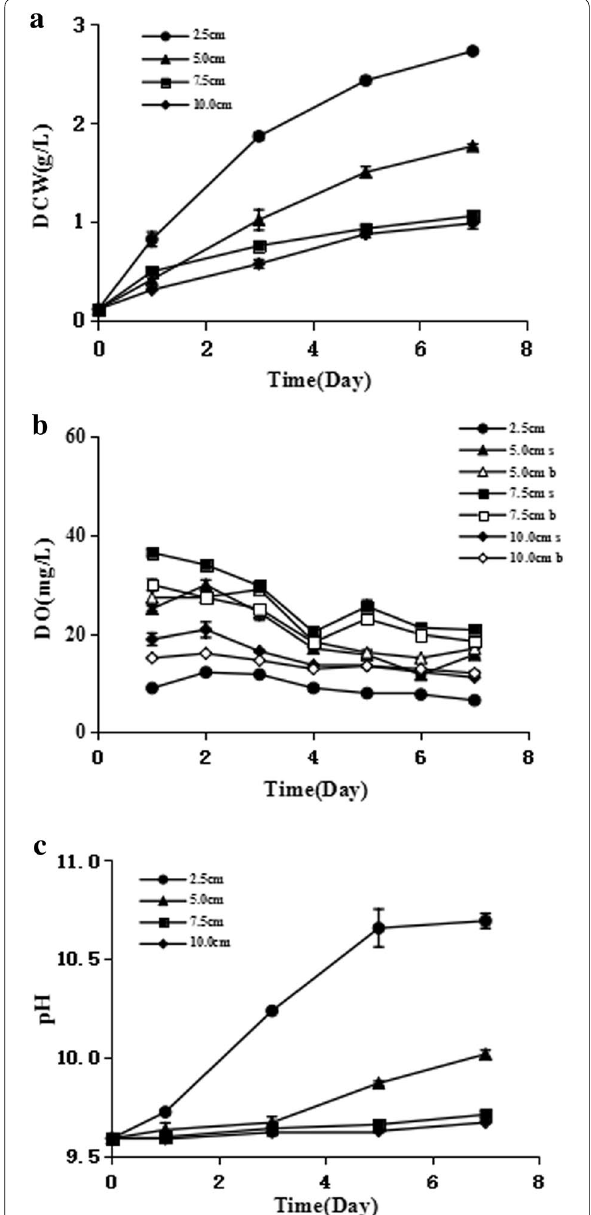
Fig. 2 Culture of Euhalothece sp. ZM001 in horizontal PBR with rocking cycle of 1 s and light intensity of 340 μmol/m 2 /s: a biomass production; b dissolved oxygen (s: surface; b: bottom); c pH